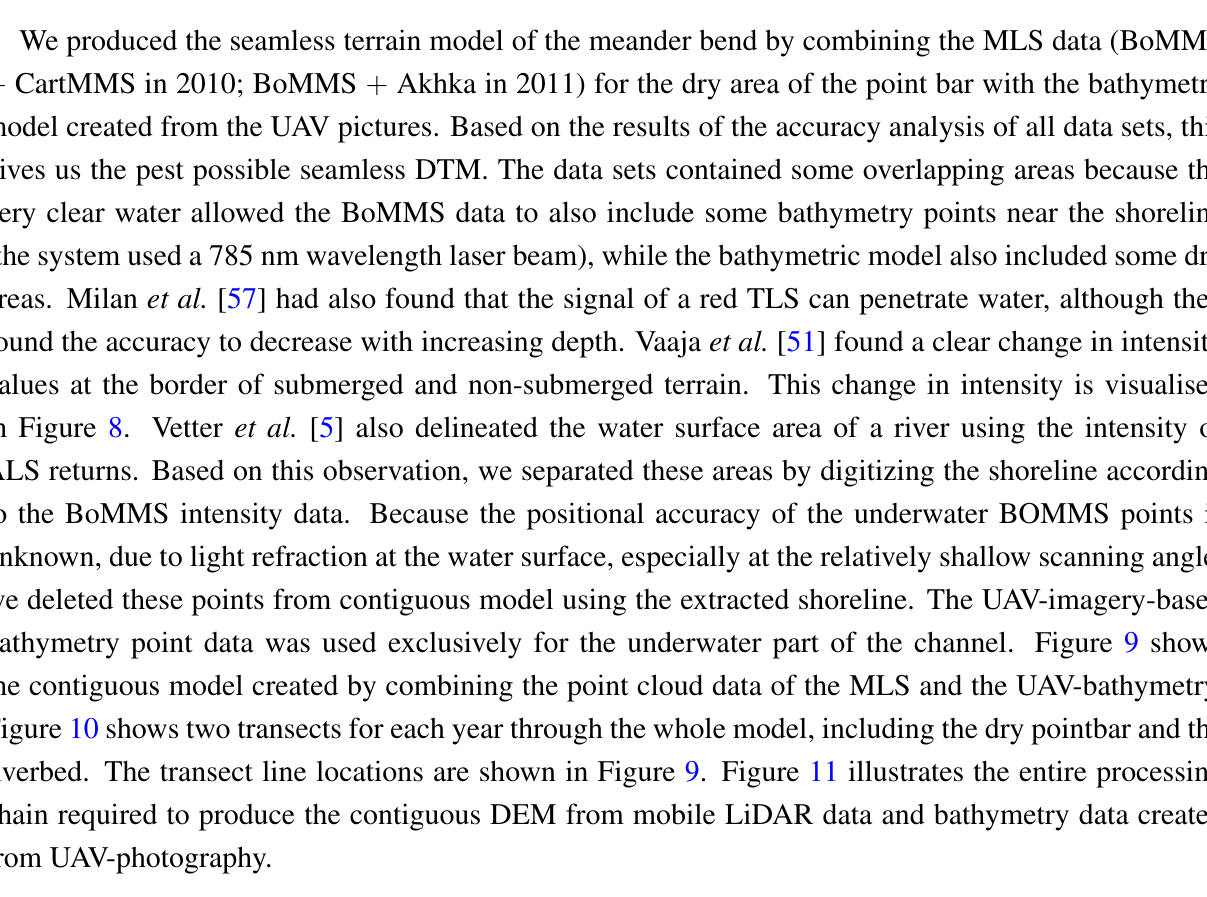
Figure 8. Map of the BoMMS intensity data of 2010 ( left ) and 2011 ( right ) used to determine the shoreline (marked in red). The intensity change at the edge between inundated and non-inundated river bed that is used in the digitization of the shoreline is clearly visible in the scatterplot of the transect marked in